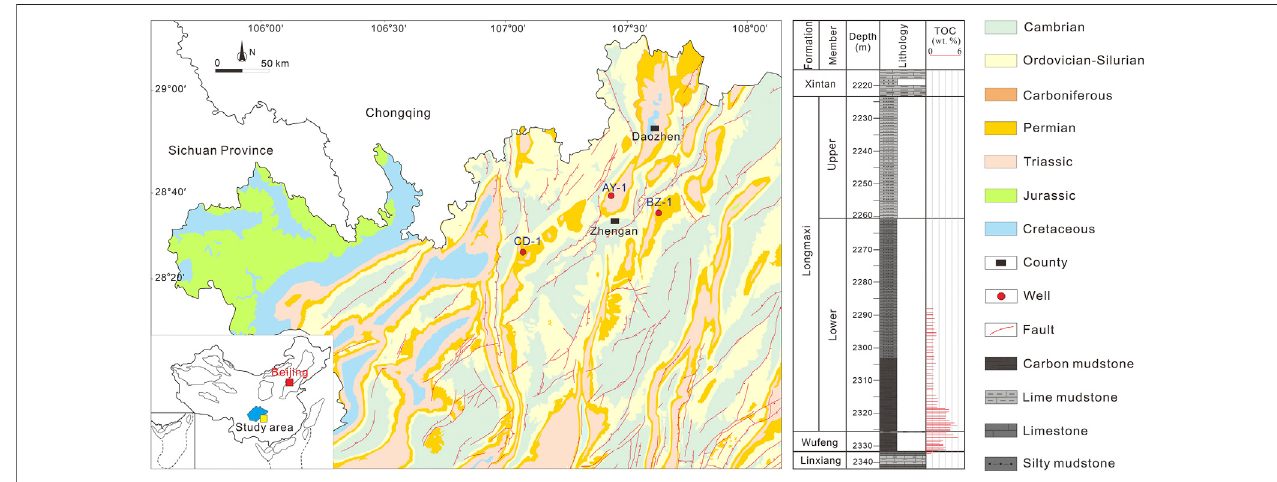
FIGURE 1 | Simpli fi ed geological map of the northern Guizhou